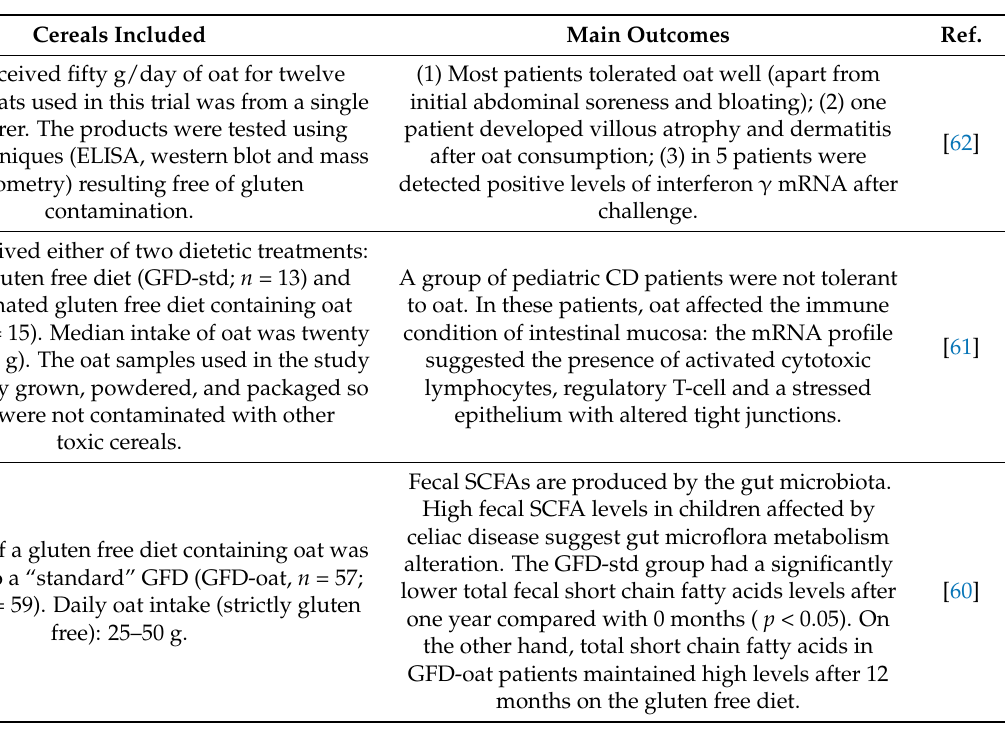
Table 7. In vivo studies on the toxicity of A. sativa for celiac subjects with negative